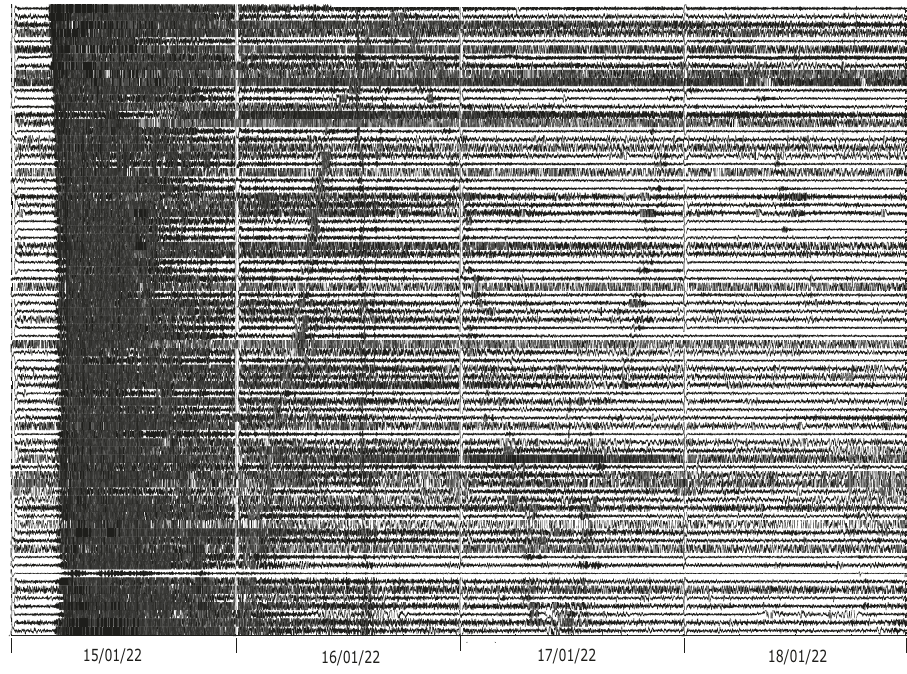
Fig. 3 Seismic record of the successive passages of the atmospheric Lamb wave in stations distributed throughout the planet. The data have been band-pass fi ltered between 0.5 and 5 mHz, classi fi ed according to their distance from Hunga-Tonga and represented without amplitude normalization.